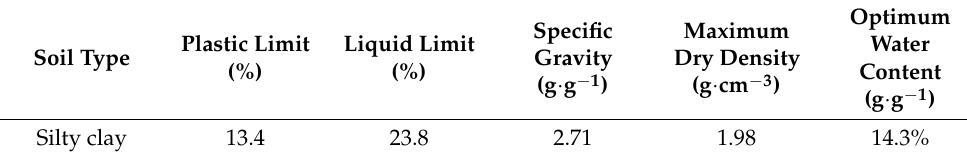
Figure 1. The grain size distribution measured curve of silty clay samples. Table 1. Physical properties of Qinghai-Tibet Plateau silty